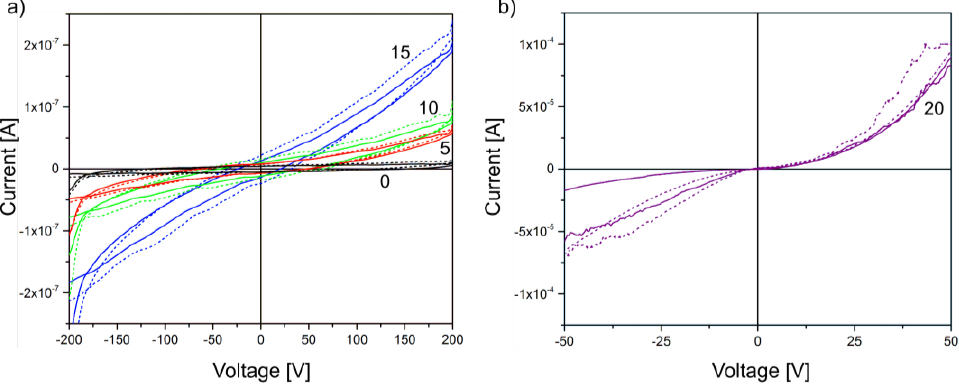
Figure 6 . I-V curves of (Cd:Zn)S/P(VDF-TrFE) composite films without (solid lines) and with (dotted lines) optical excitation in dependence on the (Cd:Zn)S particle concentration: ( a ) 0 to 15 vol % (0 = 0 vol %, 5 = 5 vol %, 10 = 10 vol %, 15 = 15 vol %) and ( b ) 20 vol %. The I-V curves for a particle concentration of 0.1 and 1 vol % (not shown in this figure) are very similar to pristine P(VDF-TrFE).